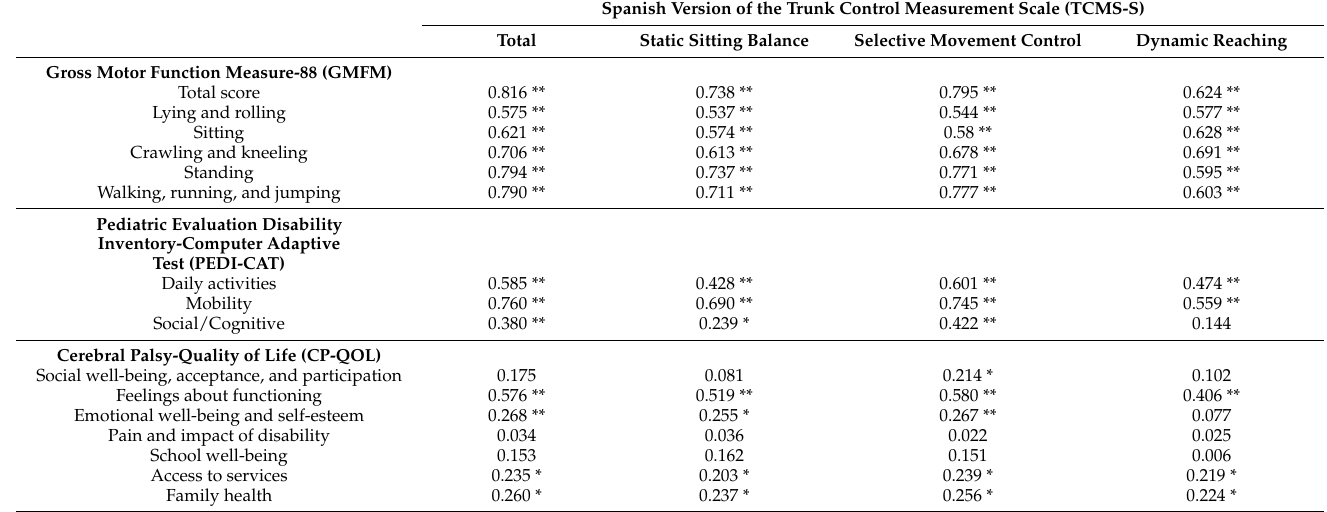
Table 1. Spearman correlations of the Spanish version of the Trunk Control Measurement Scale with gross motor function, self-care, and quality of life. Spanish Version of the Trunk Control Measurement Scale (TCMS-S) Total Static Sitting Balance Selective Movement Control Dynamic